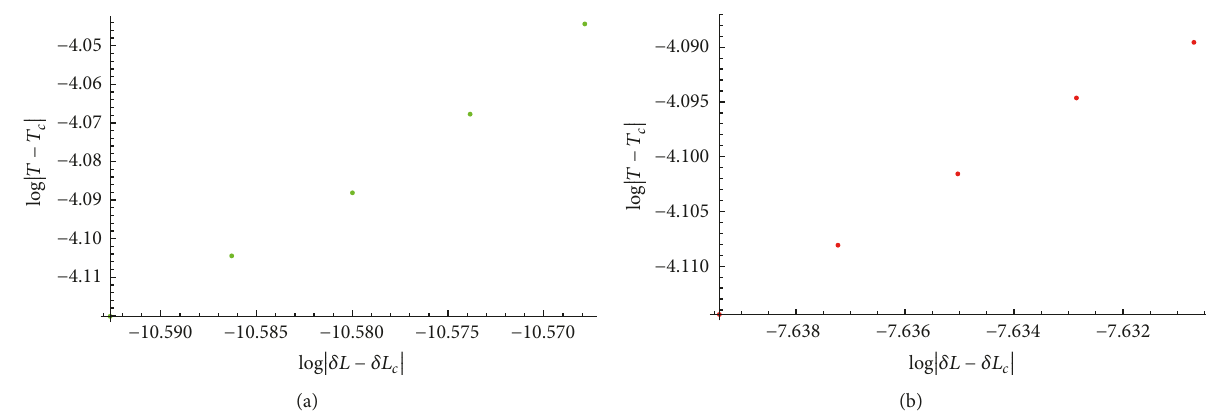
Figure 7: Relations between log |𝑇 − 𝑇 2 | and log |𝛿𝐿 − 𝛿𝐿 𝑐 | for the case 𝑞 = 0.05, 𝑒 = 𝑒 𝑐 . (a) corresponds to the case 𝜃 0 = 0.1 while (b) corresponds to 𝜃 0 = 0.2